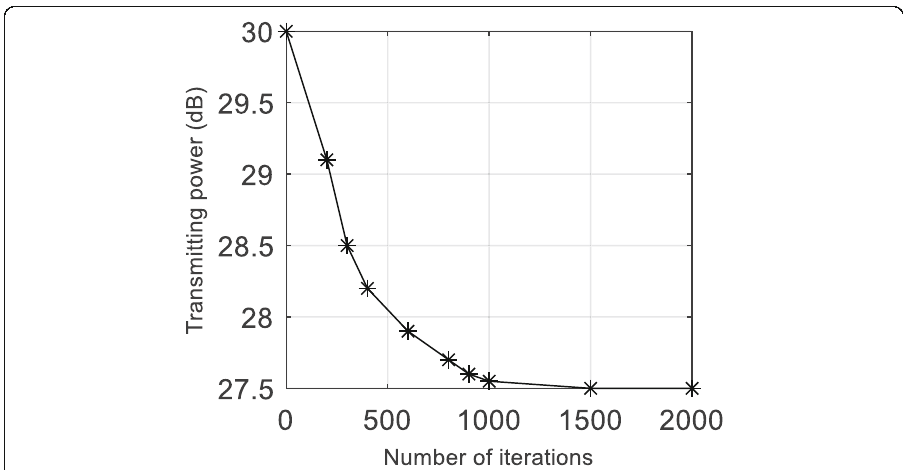
Fig. 3 The transmitting power varies as the number of iterations changes. y -axis represents the total transmitting power of the source node S achieved by the proposed optimization scheme; x - axis represents the number of